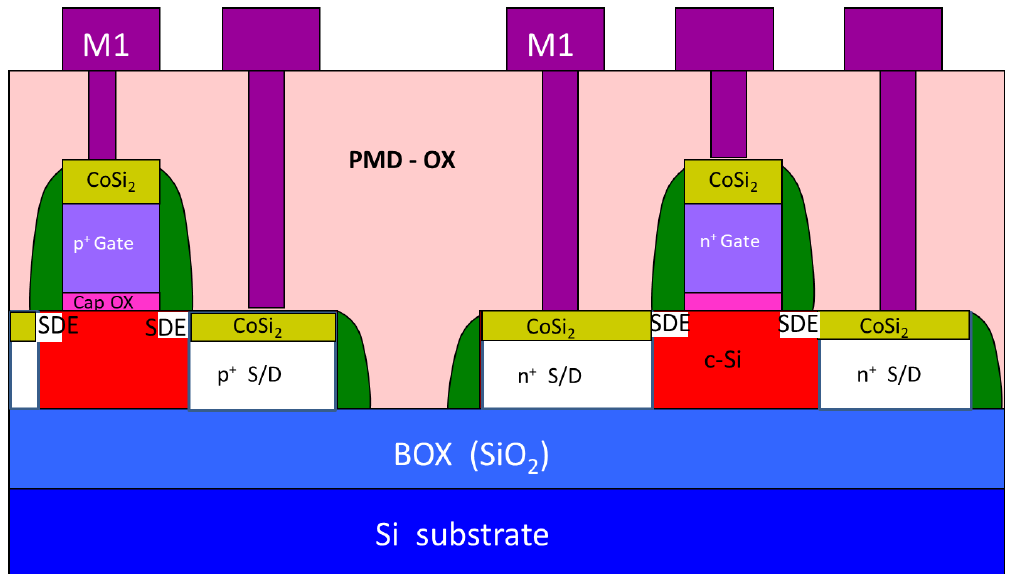
Figure 4. The cross-sectional profile of a complementary n/p-channel FinFET.